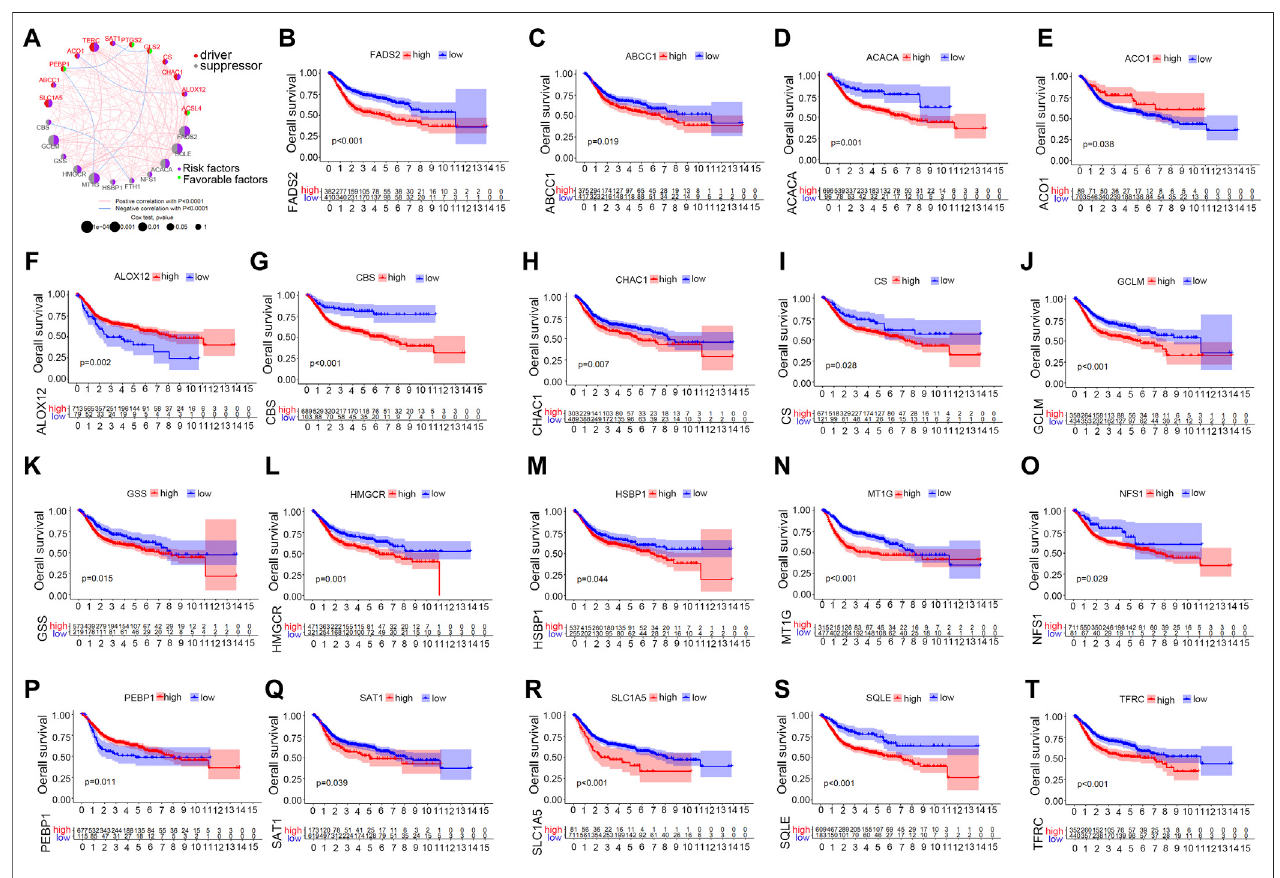
FIGURE 2 | The prognostic role of ferroptosis-related genes in the merged cohort. (A) A network illustrating interactions between 23 ferroptosis-related genes. (B – T) Kaplan-Meier analysis of 19 ferroptosis-related genes with prognostic roles in bladder cancer in the merged cohort.